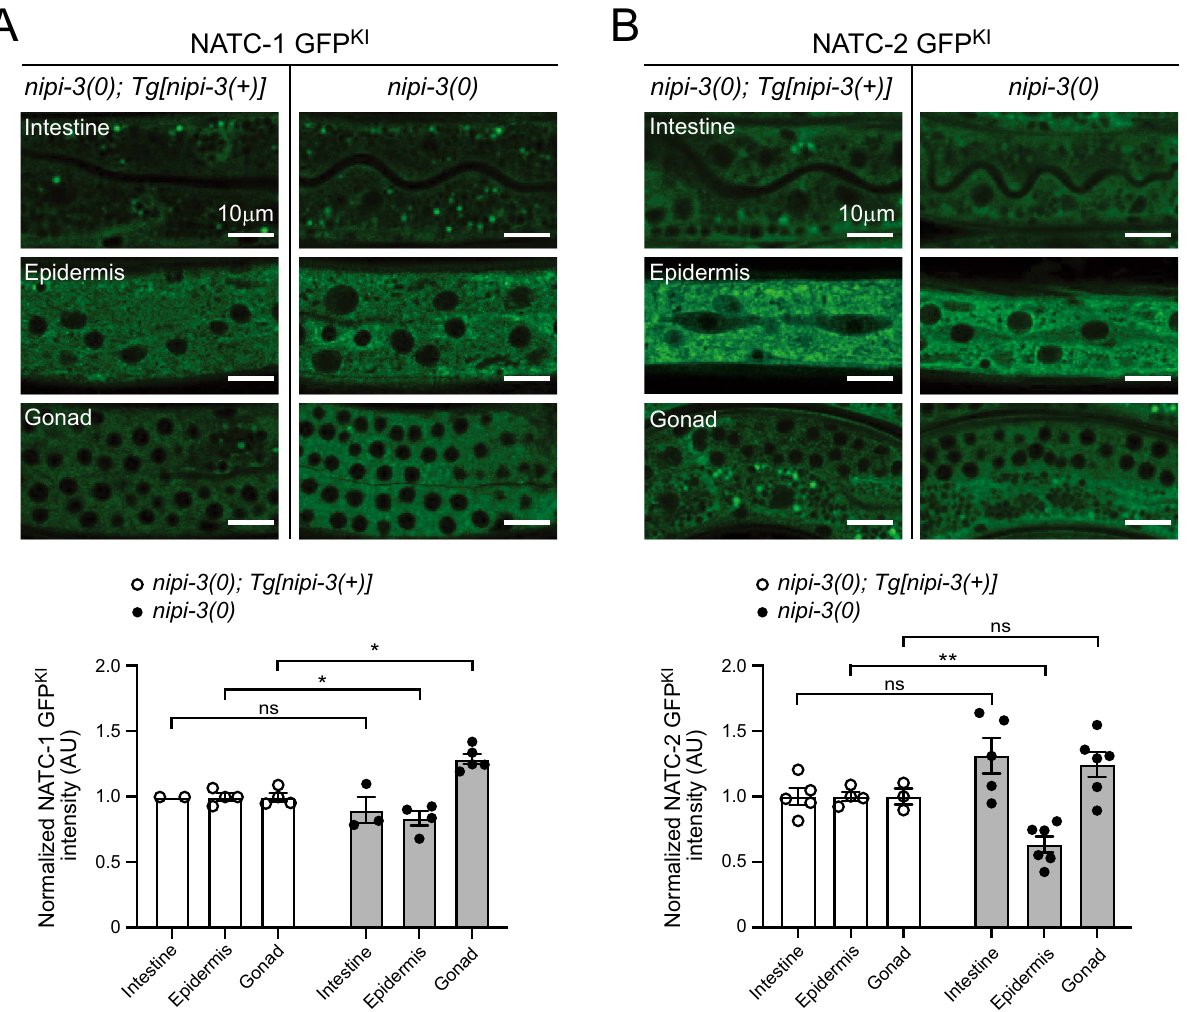
Figure 2. NIPI-3 has minimal effects on NATC-1 and NATC-2 expression. ( A, B ) Single plane confocal images of ( A ) NATC-1 GFP KI ( ju1801 ) and ( B ) NATC-2 GFP KI ( ju1803 ) in L3 animals. The left column of images is in the background of nipi-3(0); Tg[nipi-3( + )] , which has expression of WT nipi-3 transgene (Tg), rescuing the larval arrest phenotype. Scale bar = 10 µm. The bar graph overlaid with a dot plot (bottom panels) represents quantification of the images with ImageJ software. Statistics: Mann–Whitney test. ns , not significant, * P < 0.05, ** P <